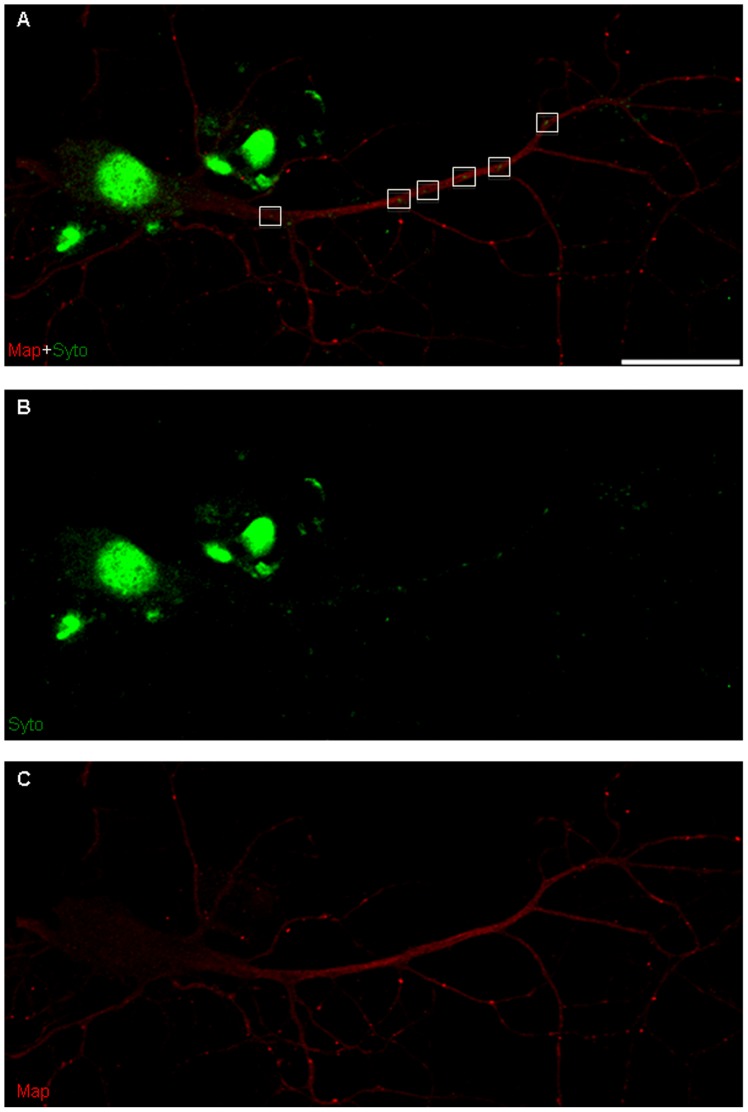
Confocal microscopy of mRNA localization in dendrites.(A) Double-label immunofluorescence shows Syto labeling in cell bodies (nuclear) and co-localization of mRNA (Syto, green) with a dendritic marker (MAP2, red). Green puncta (Syto) that are not co-labeled correspond to localization within axons. (B) Immunofluorescence of mRNA (Syto, green). (C) Immunofluorescence of dendritic marker (MAP2, red). Bar is 50 µm.